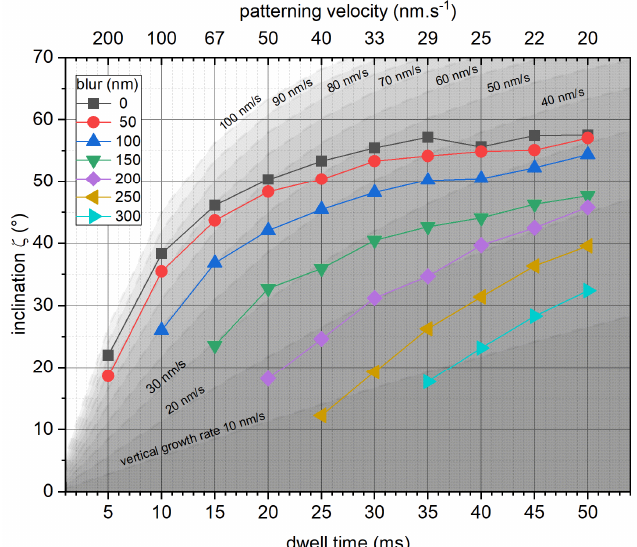
Figure 1. Implications of blurred electron beams on inclination ζ during 3D- focused electron beam induced deposition (FEBID). ζ is plotted as function of dwell time/patterning velocity for in-focus conditions and blurred electron beams at 5 keV/28 pA. The shaded areas indicate constant vertical growth rates (see main text). In contrast to the segments’ inclination, both segment-width and -thickness (measured perpendicular to the segment axis) increase with blur. Figure 2a shows the width in dependence of applied beam blur, grouped with respect to the applied DT. For in-focus settings, segment widths are between 50 and 75 nm. With increasing blur, the widths monotonically increase up to ~200 nm for the highest beam blurs of 300 nm, which means an increase by a factor of 2.6. The insets in Figure 2a show selected in-scale top view SEM graphs of DBs highlighting the width tunability. To avoid inclination dependent width convolutions, DBs presented in the inset are of comparable inclination. The dashed line in Figure 2a indicates the actual beam diameter. As is evident, the beam diameter is smaller than the segments for in-focus conditions. For higher blur values, the situation reverses, and the segment widths are below the beam diameter, which means that a fraction of primary electrons within the low intensity beam tails never impinge on the deposited structure. Segment thicknesses against blur are plotted in Figure 2b, again, grouped w.r.t applied DTs. At the in-focus conditions, segment thickness ranges between 40 and 90 nm, while the introduction of the beam blur increases the thickness by a factor of around three up to 275 nm (50 ms DT, see legend in Figure2c). As a consequence of increasing widths and thicknesses, cross-sectional areas (elliptically modelled in agreement with our previous work [3]) increase as well, as summarized in Figure 2c. This -quantity is of particular interest for many application related properties. The mechanical load capacity and section modulus as well as electric or thermal properties are directly connected to the cross-sectional area. Across the applied settings, cross-sectional areas increased by almost one order of magnitude (~8.7 for DT 35 ms). The aforementioned gain in structural dimensions is solely down to increasing beam diameters, while the